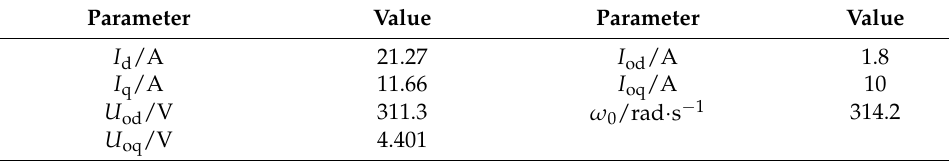
Table 2. Steady-state operating points of the single-VSG